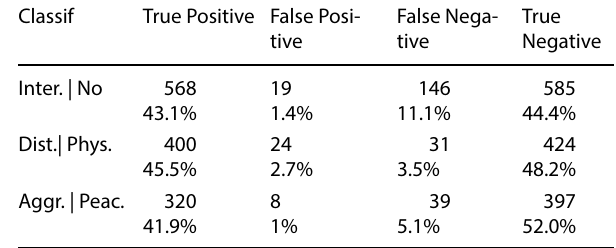
Table 6 Results for the three classification DNN